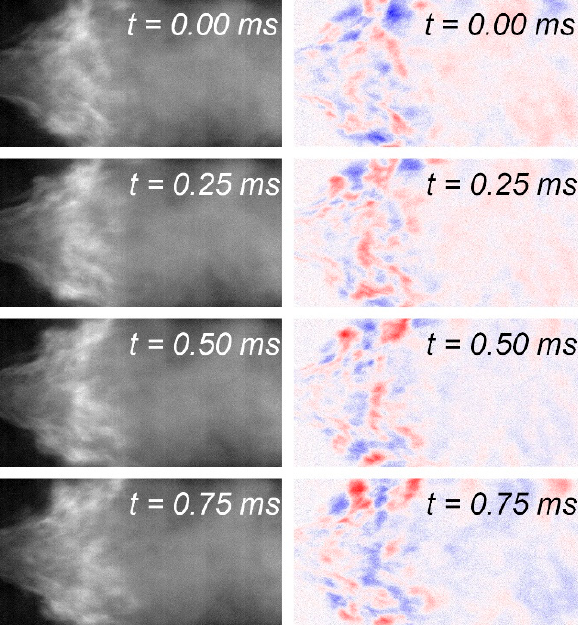
Figure 15. Representative instantaneous flame images ( left ) and their oscillating components ( right ) using C 2 H 4 at L C = 795 mm, SN = 0.80, u = 20 m/s, and ϕ = 0.80.